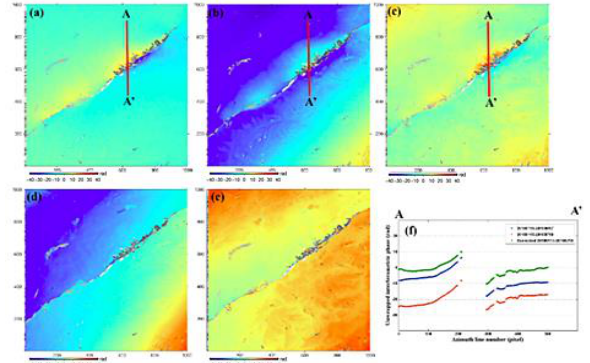
Figure 5. Ionospheric correction by using the azimuth offset method. (a) Unwrapped phase for interferometric pair 1 in Table 1; (b) unwrapped phase for interferometric pair 2; (c) ionosphere-corrected unwrapped phase for interferometric pair 2 estimated using the azimuth offset method; (d) phase difference between (a) and (b); (e) phase difference between (a) and (c); (f) the phase values in the profile A-A’ of (a)-(c).